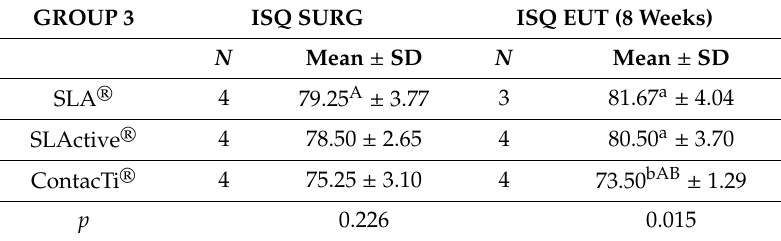
Table 3. Relative means of the ISQ value in the measurements performed in group 2 (euthanasia at 8 weeks), both on the day of surgery (ISQ SURG) and at the time of euthanasia (ISQ-TSU), for each of the three groups. The lowercase letters show in standard form (columns) the di ff erences in pairs between the means by the Tukey method after detecting statistical significance in the ANOVA.